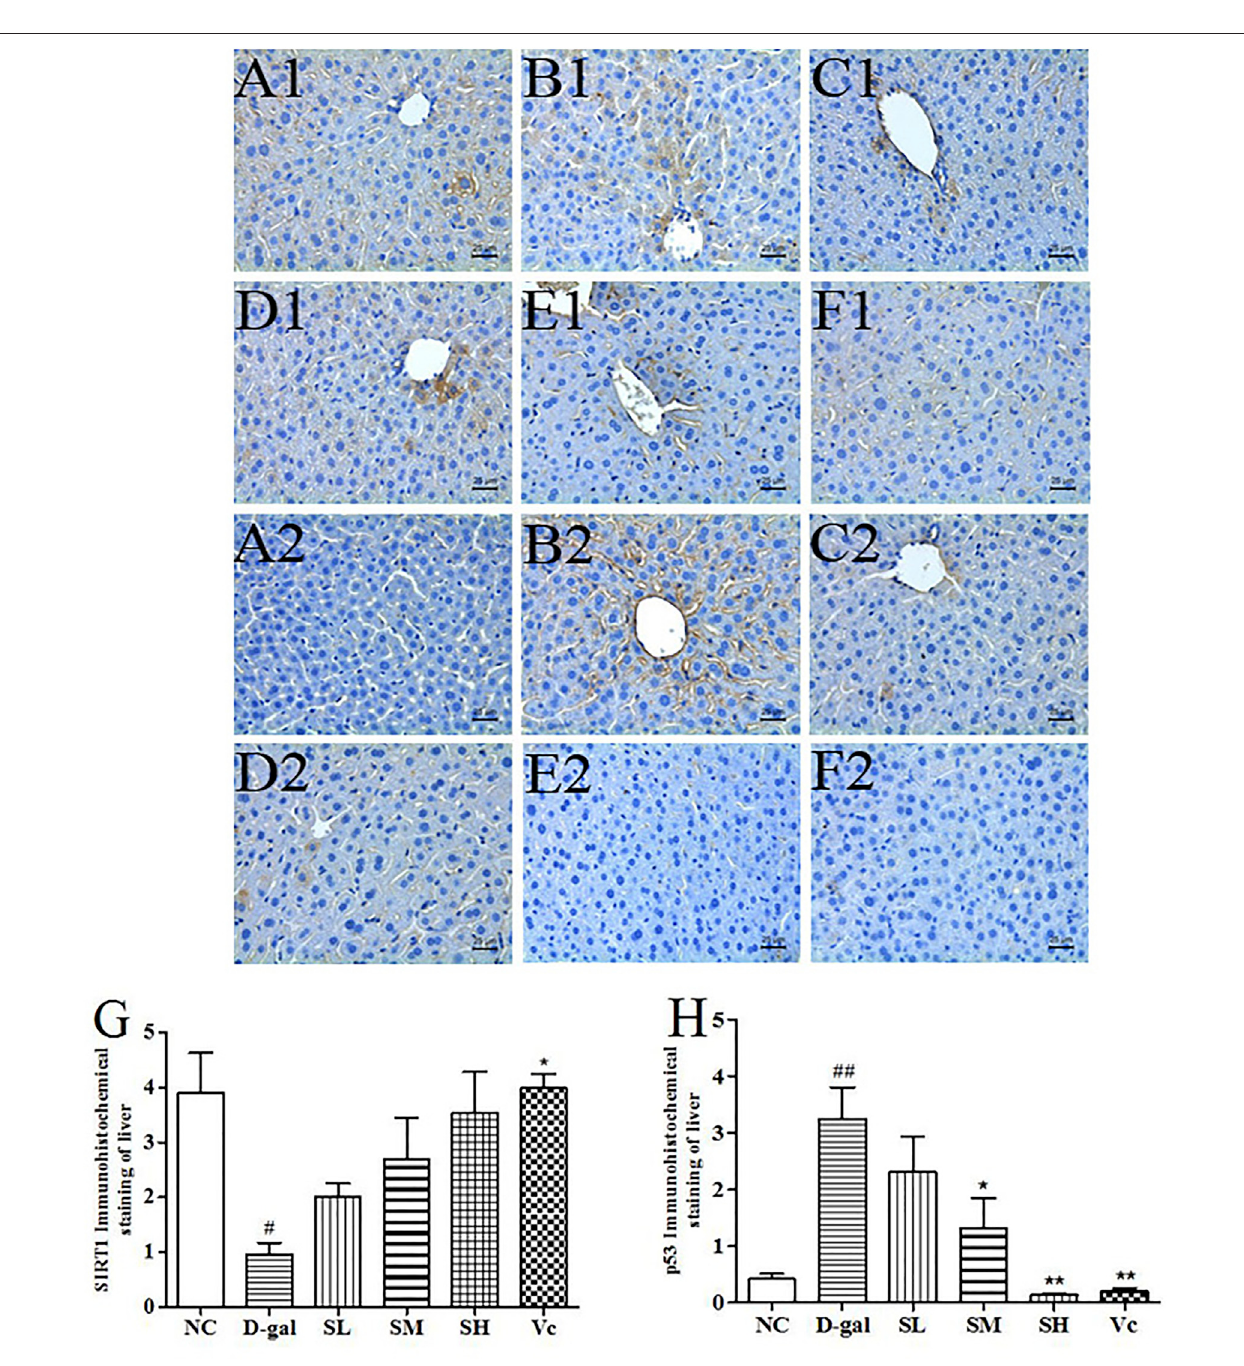
FIGURE7| TheSIRT1andp53proteinexpressionsinthelivertissuesofeachgroup( × 400).SIRT1(A1 – F1),A1:NCgroup,B1:D – galgroup,C1:low – dosegroup, D1: medium – dose group, E1: high – dose group, F1: Vc group; p53 (A2 – F2), A2: NC group, B2: D – gal group, C2: low – dose group, D2: medium – dose group, E2: high – dose group, F2: Vc group. G: The SIRT1 positive staining area in each group; H: The p53 positive staining area in each group. Compared with normal group, #: p < 0.05; ##: p < 0.01; Compared with D – gal group, *: p < 0.05, **: p < 0.01. NC: normal control group; D – gal: D – gal model group; SL: low – dose SDE group; SM: medium – dose SDE group; SL: high – dose SDE group; Vc: Vc positive control group.